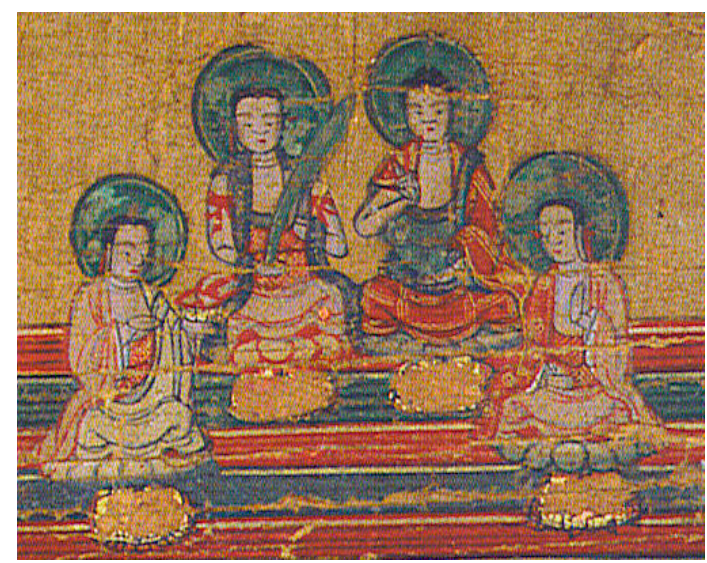
Figure 10. Four Great Venerable Buddhas (Gulácsi 2016, Figure 6/17 [p. 368]).